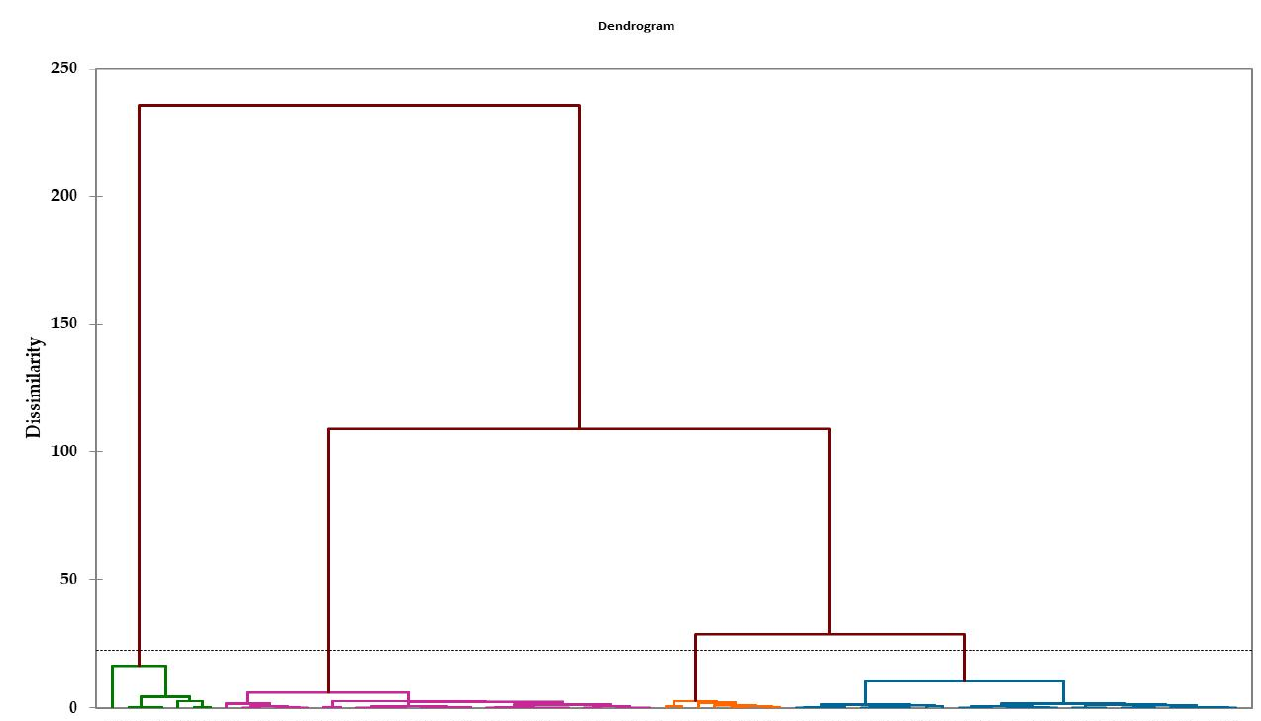
Figure 5. Hierarchical cluster derived by Ward’s methods of 70 barley genotypes based on salt tolerance indices of germination and seedling shoots and roots traits measured under control and salinity conditions. The full names of genotypes are listed in Table 1. The genotypes formed cluster 1 attained the highest STI values for G% and GI and Table 7. Mean values of stress tolerance index for different germination and seedling traits under lowest values for MGT under two salt concentrations followed by the genotypes in different salt concentrations of the four clusters of 70 barley genotypes.